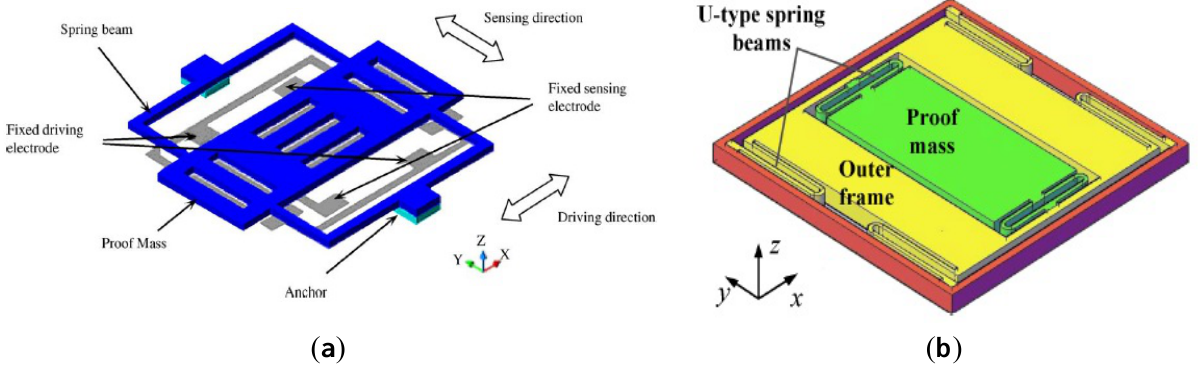
Figure 23. Slot-structure gyroscopes. ( a ) SIMIT. ( b ) Zhejiang